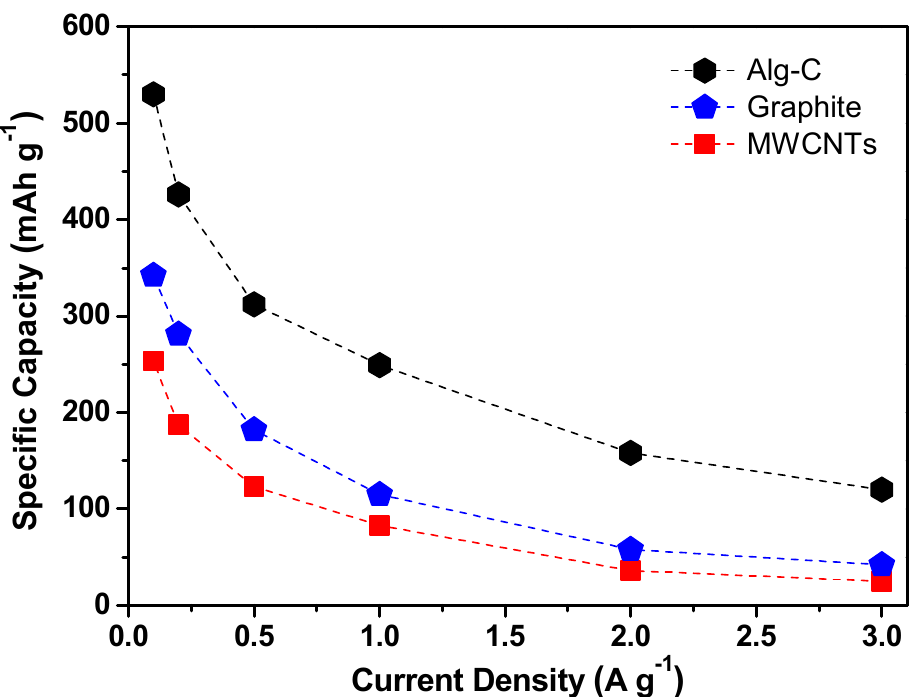
Figure 8. Comparison of the rate capabilities of Alg-C, graphite, and MWCNTs under various current densities within the potential window from 0.02 to 3.0 V.